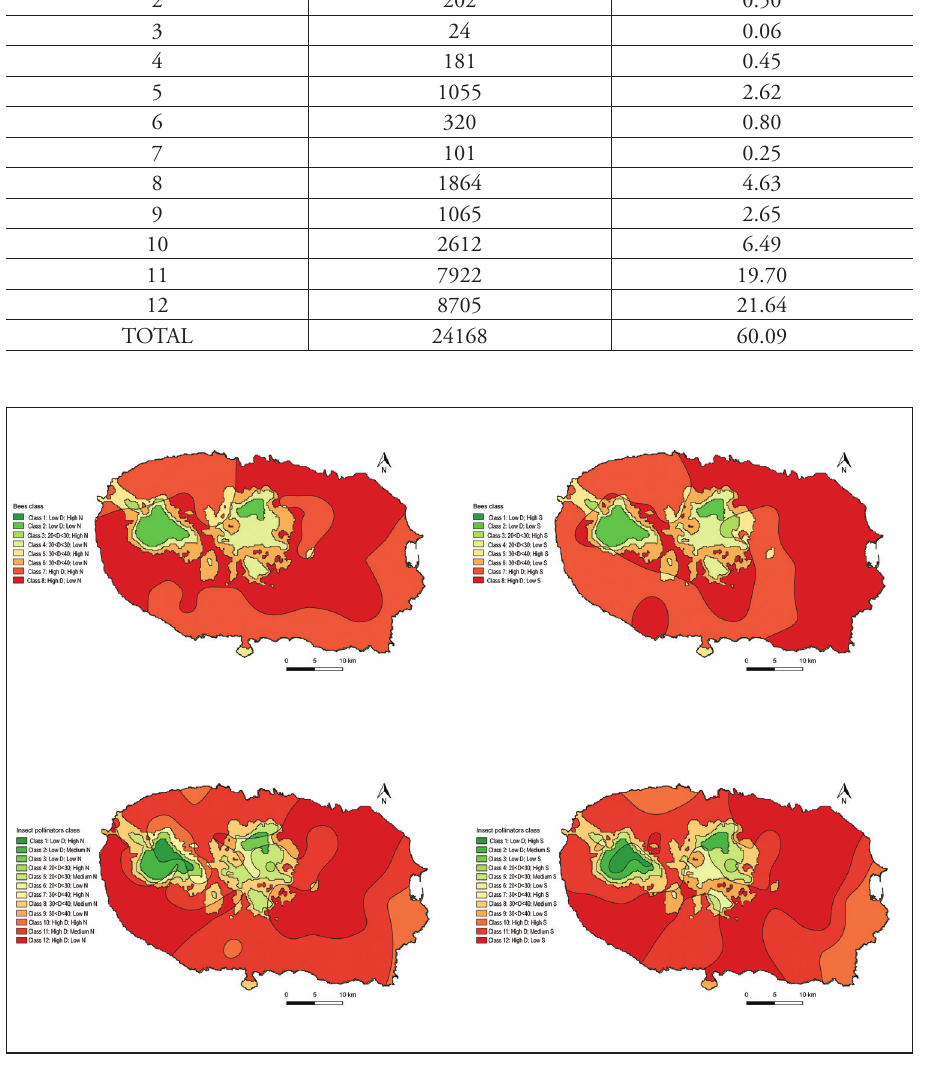
Figure 3. Classification maps of pollination services according to the influence of disturbance index (D): (upper left) bees abundance (N); (upper right) bees richness (S); (lower left) insect pollinators abundance (N); (lower right) insect pollinators richness